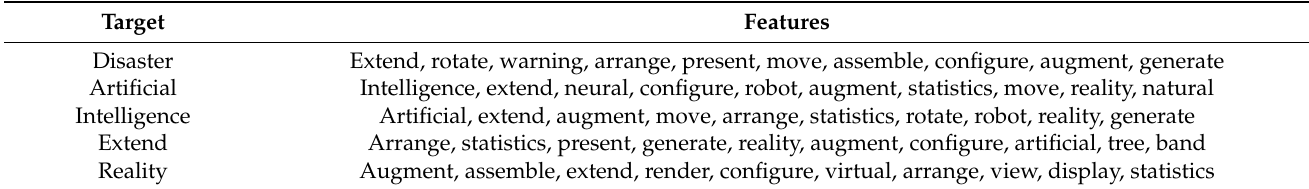
Table 4. XGboost results of feature selection for targets.